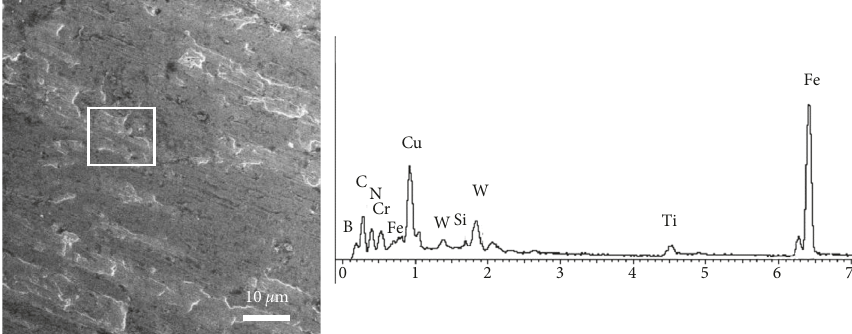
Figure 14: SEM image and EDS spectrum of the worn surface from the ball